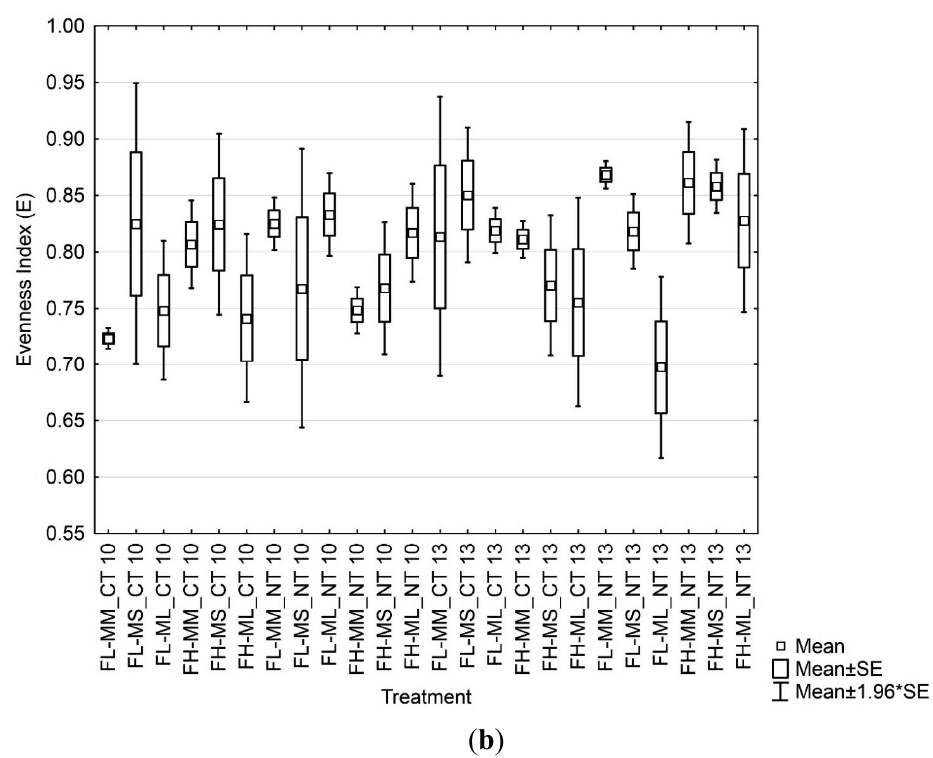
Figure 3. ( a ) Box and Whisker plots comparing the effect of different CA practices on soil microbial species richness (Shannon–Weaver Index) during the 2009/2010 and 2012/2013 planting seasons; ( b ) Box and Whisker plots comparing the effect of different CA practices on soil microbial species abundance (Evenness Index) during the 2009/2010 and 2012/2013 planting